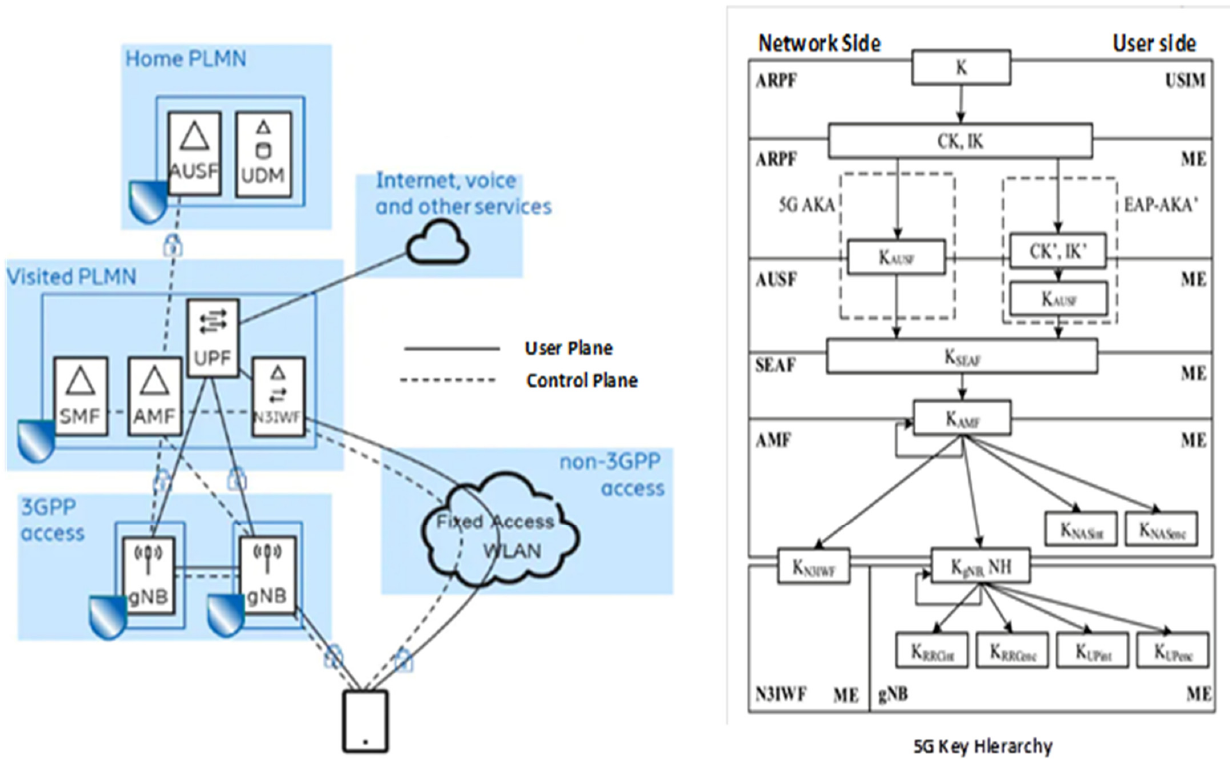
Figure 6. 5G Basic Security Architecture and key hierarchy (adapted from [75]).